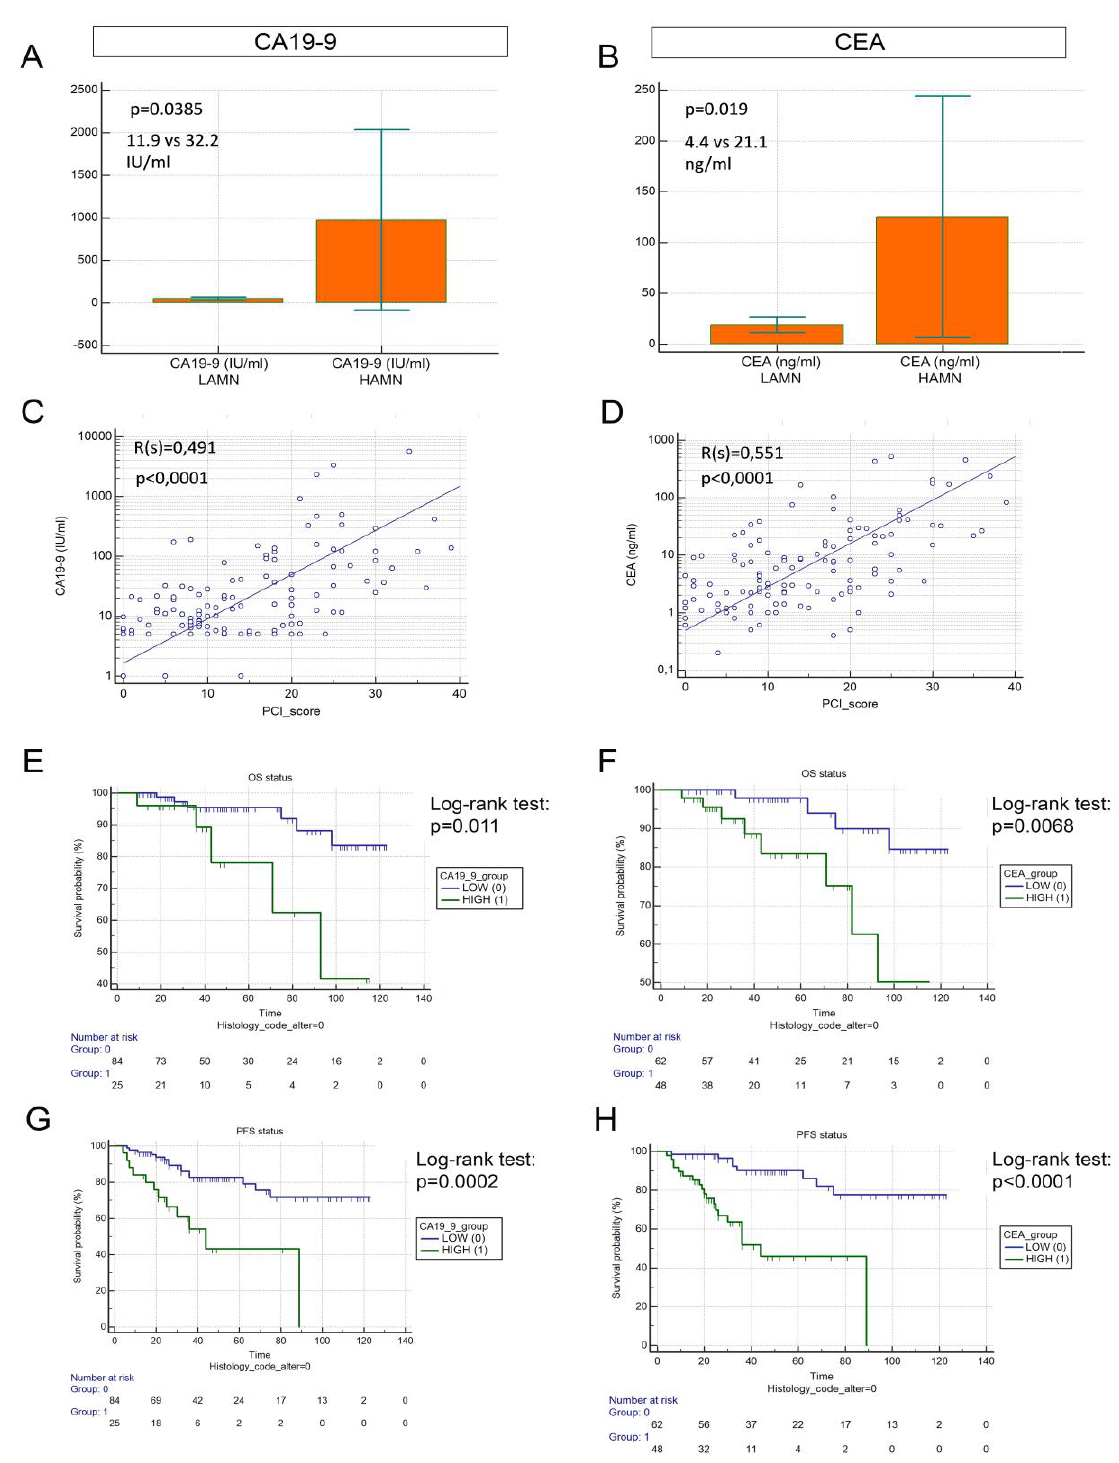
Figure 2. Tumor markers in PMP. CA19-9 and CEA plasma levels were significantly increased in HAMN patients compared to LAMN patients ( A , B ). PCI showed a moderate positive correlation with the plasma levels of both tumor markers according to Spearman’s rank correlation ( C , D ). Both CA19-9-low and CEA-low patients exhibited significantly better outcomes (compared to CA19-9- and CEA-high patients) including OS (CA19-9: 114.16 vs. 85.88 months, p = 0.0110 ( E ); CEA: 115.47 vs. 90.43 months, p = 0.0068 ( F )) and PFS (CA19-9: 99.7 vs. 51.93 months, p = 0.0002 ( G ); CEA: 106.7 vs. 54 months, p < 0.0001 ( H )). Months for OS and PFS are described as means .